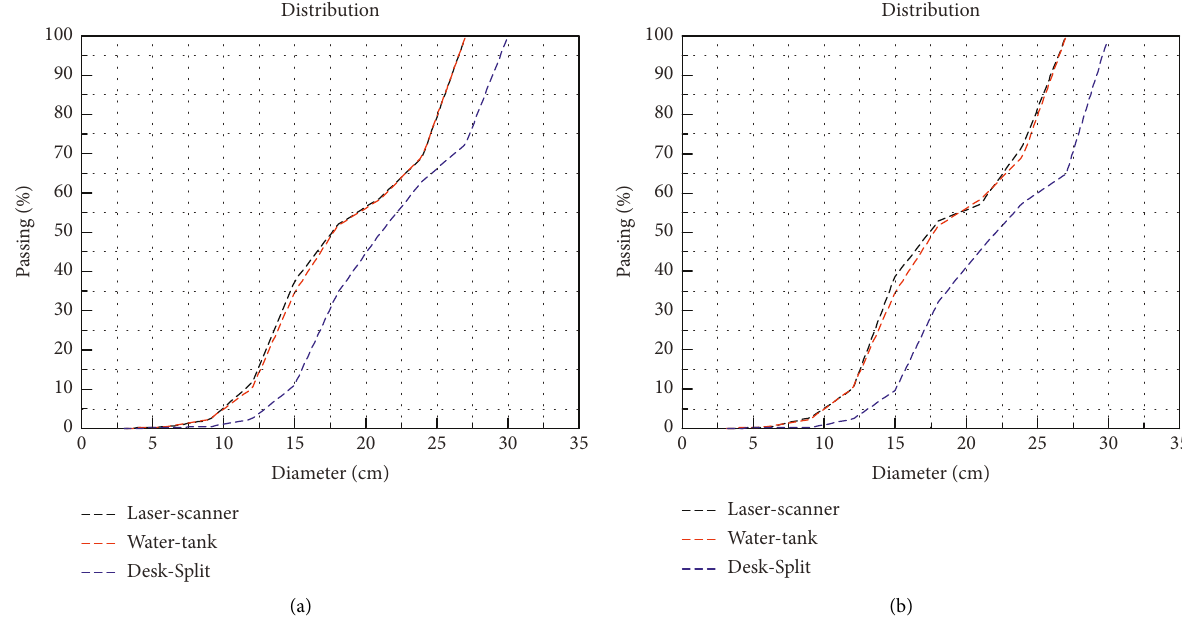
Figure 10: Size distribution of the scattered blocks. (a) Case 1. (b) Case 2. Table 2: Frequency count for the surface rock blocks in the lab experiments. (a) Case 1. (b) Case 2. Diameter (cm)